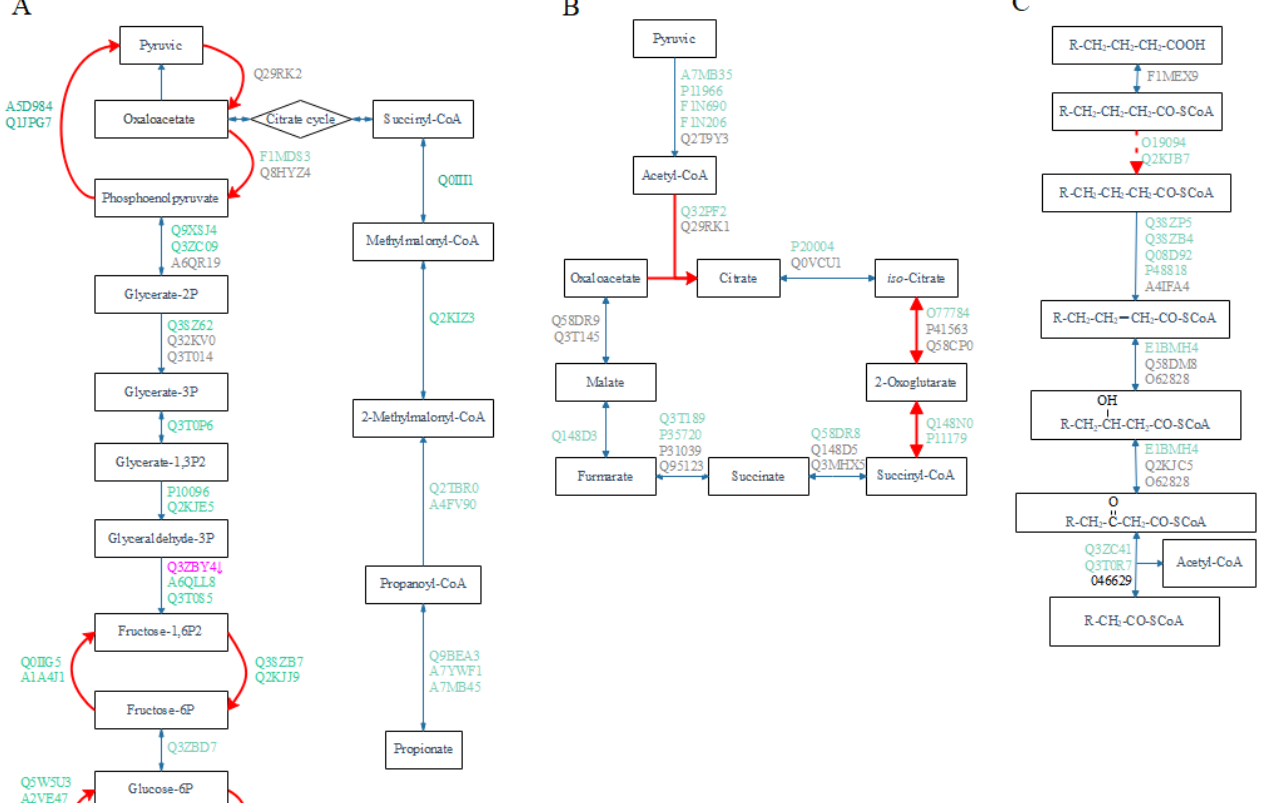
Figure 3. Hepatic metabolism pathway of glucose, citric acid cycle and fatty acid metabolism as influenced by rumen-protected protein (RPG) supplementation. ( A ) Glycolysis/glycogenesis. ( B ) Citrate cycle. ( C ) β -oxidation of fatty acid. The red arrows show the rate-limiting steps in each metabolic pathway. For each protein code, the gray color indicates no detection, green indicates no effect caused by RPG supplementation, and purple indicates a decrease in the RPG treatment group.